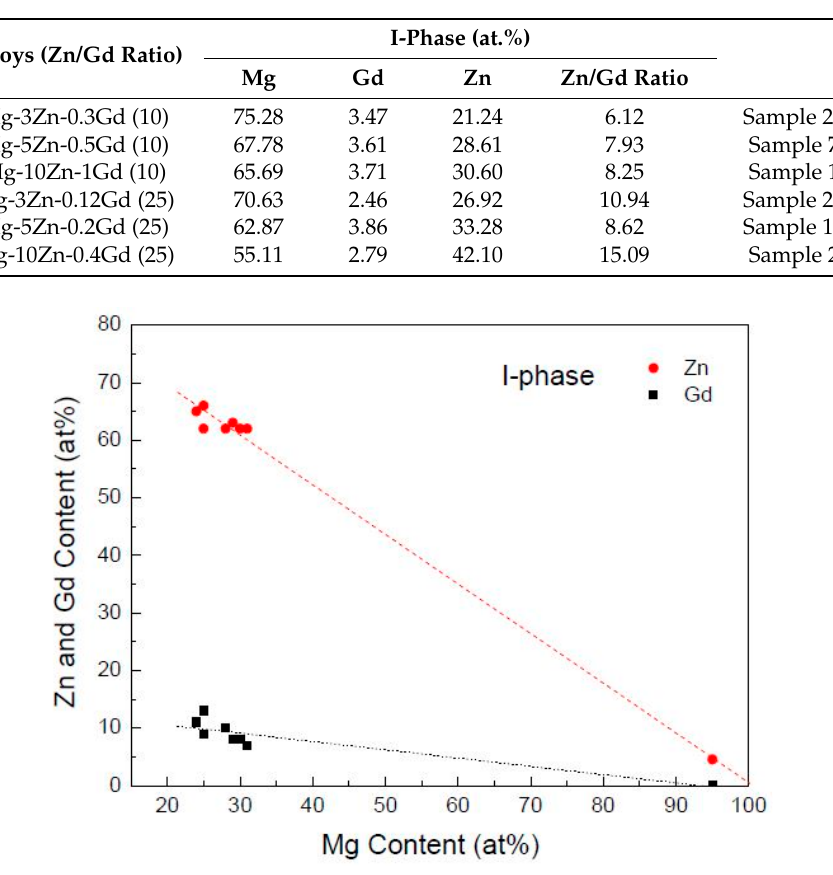
Figure 10. Contents of Zn and Gd of I-phases (Zn/Gd = 6:1) in Mg-1Zn-0.333Gd alloy (Sample 39) plotted as a function of the Mg content by EDS with TEM.